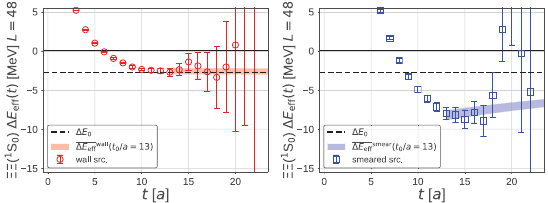
Figure 17. E ff ective masses associated with ΞΞ ( 1 S 0 ) correla- tors using (left) a wall source and (right) a local smeared source. The dashed line indicates the asymptotic behavior using the wall source, and this result also agrees with the HAL QCD method. The key point, shown in the right plot, is the disagreement be- tween the dashed line and the apparent plateau of the e ff ective mass points in blue obtained using the local smeared source. The shaded blue band in the right plot is the expected large-time be- havior. These results are from Ref. [20].